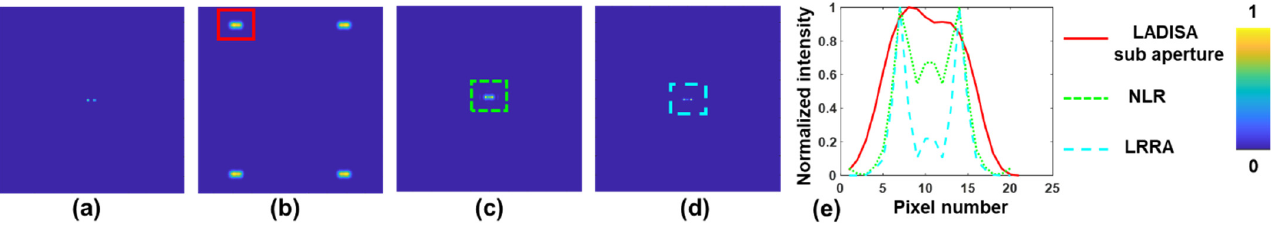
Figure 7. Simulated intensity distribution for an object consisting of only two points using ( a ) the ideal diffractive lens and ( b ) LADISA with four sub-apertures. Reconstruction results of ( b ) using ( c ) NLR and ( d ) LRRA. ( e ) Plots of the line data extracted from ( b – d ).